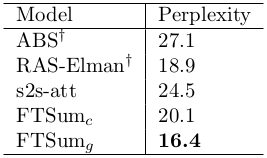
Table from the paper: Faithful to the Original: Fact Aware Neural Abstractive Summarization
Table text:
Model
Perplexity
ABS †
27.1
RAS-Elman †
18.9
s2s-att
24.5
FTSum c
20.1
FTSum g
16.4